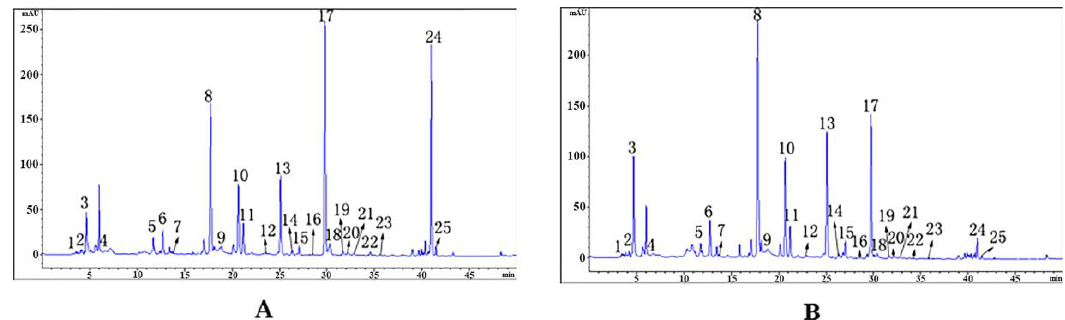
Figure 1. The HPLC chromatograms of RGE-fresh ( A ) and RGE-steamed ( B ) samples.